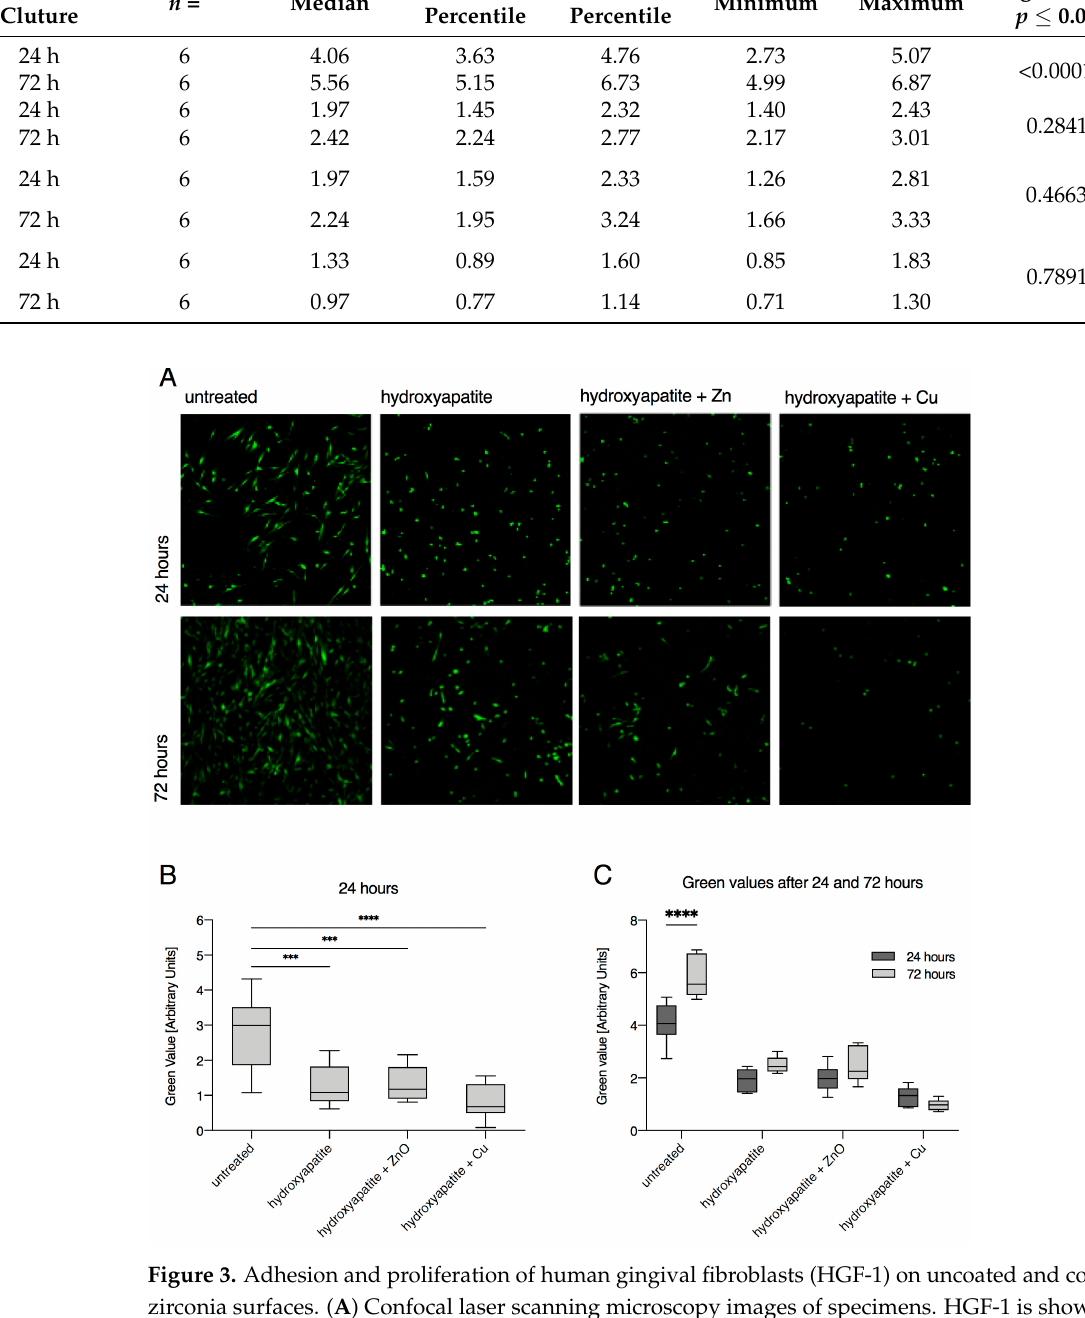
Figure 3. Adhesion and proliferation of human gingival fibroblasts (HGF-1) on uncoated and coated zirconia surfaces. ( A ) Confocal laser scanning microscopy images of specimens. HGF-1 is shown in green (green value) by the fluorescent dye CMFDA. Shown are representative images after 24 h and 72 h of cell cultivation. ( B ) HGF-1 green value after 24 h of cell cultivation. Statistically relevant differences ( p < 0.05) were found between untreated and treated specimens. *** p < 0.0005; **** p < 0.00005. ( C ) Upon comparing results for the HGF-1 green value after 24 h and 72 h of cultivation, statistically significant increases ( p < 0.05) were found for untreated specimens. **** p <